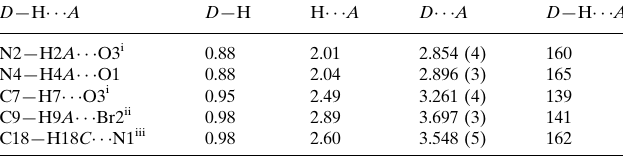
Hydrogen-bond geometry (A˚ , (cid:1) ). D —H (cid:2)(cid:2)(cid:2)